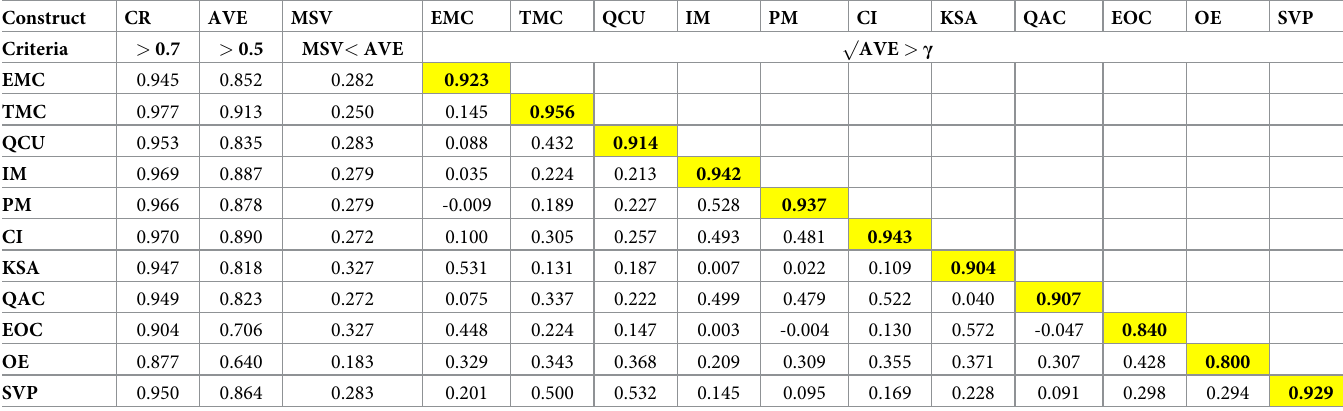
Table 3. Convergent & discriminant validity and construct reliability results of first order constructs. Construct